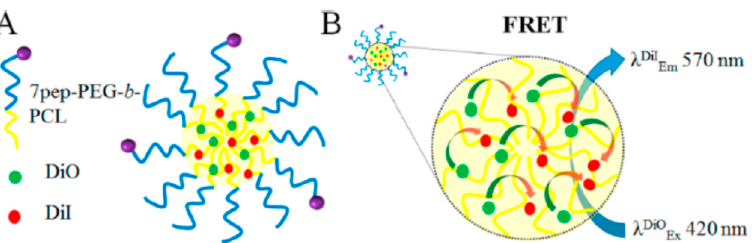
Figure 5. Schematics of the FRET micelle ( A ); concept of the FRET micelles ( B ), FRET mechanism of the DiO- and DiI-loaded micelles. Reproduced with permission from ref. [12]. Copyright 2017, American Chemical Society.